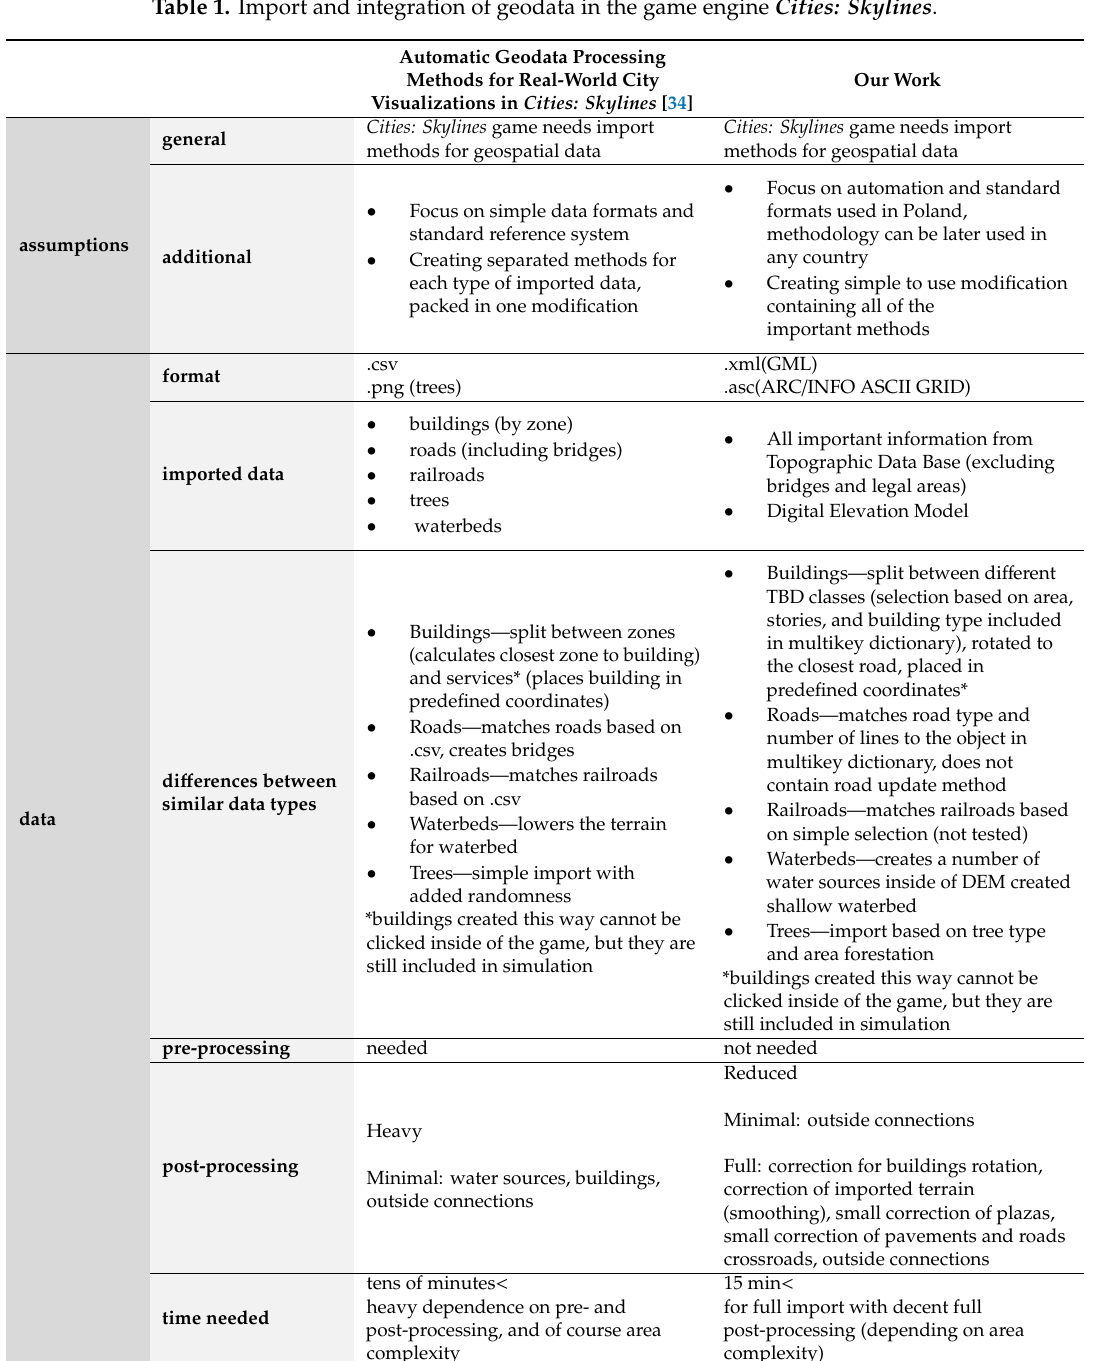
Table 1. Import and integration of geodata in the game engine Cities: Skylines